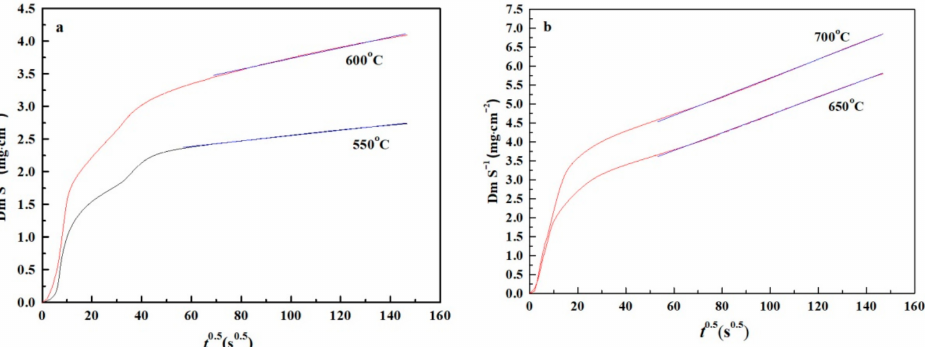
Figure 6. Mass gain vs. t 0.5 graph of the Mg coated samples, after isothermal oxidation at ( a ) 550, 600 ◦ C and ( b ) 650, 700 ◦